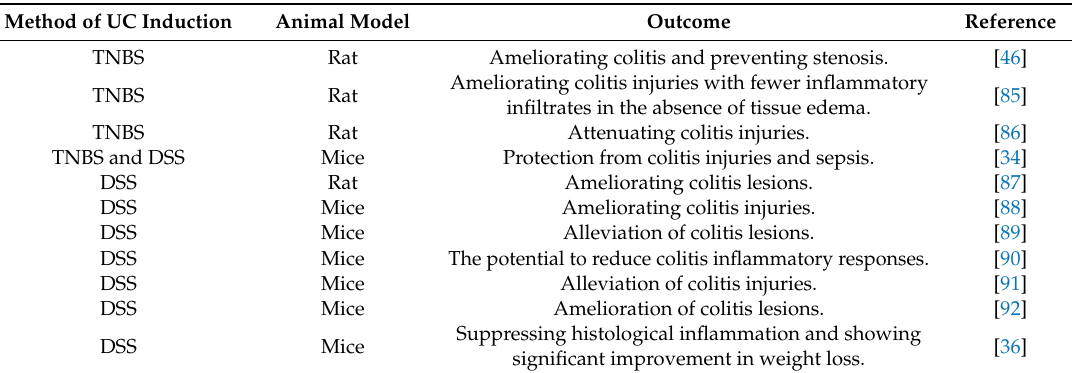
Table 5. In vivo studies in the treatment of UC using